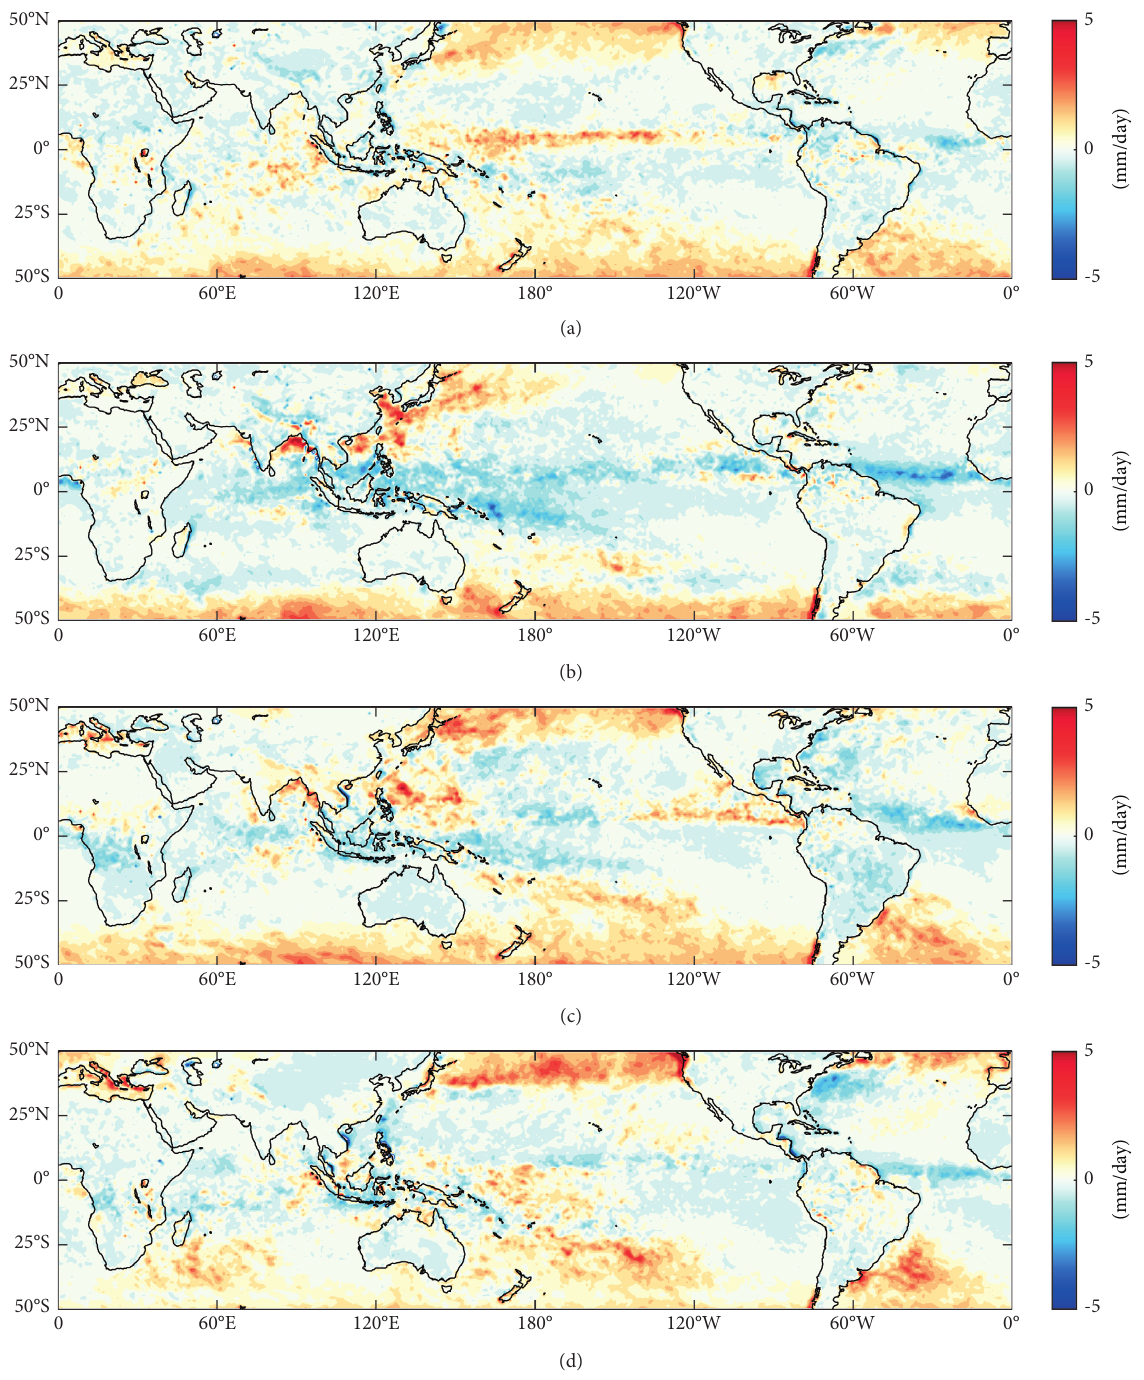
Figure 2: Differences (IMERG minus TMPA) between the mean precipitation data in the IMERG V06B product and the TMPA 3B42 product in (a) March, April, and May (MAM); (b) June, July, and August (JJA); (c) September, October, and November (SON); (d) December, January, and February